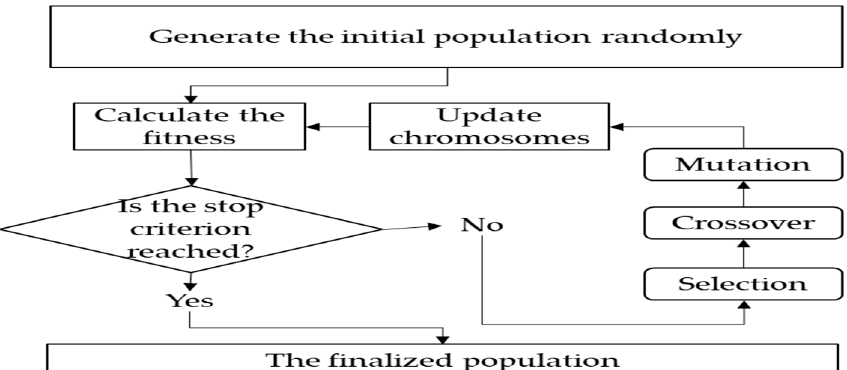
Figure 3. The flowchart of the genetic algorithm.